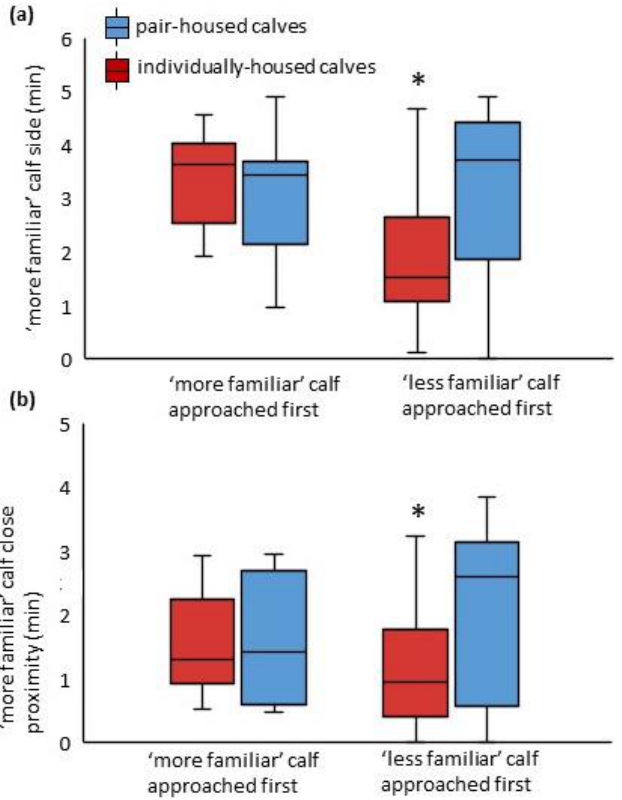
Figure 2. Effects of housing treatment and identity of first approached calf on duration of time spent on the side ( a ) or in close proximity ( b ) of the ‘more familiar’ calf, during a social preference test conducted at 4 weeks of age (at 29.3 ± 1.9 d of age). * Denotes significant pairwise difference between all other values ( p < 0.05).